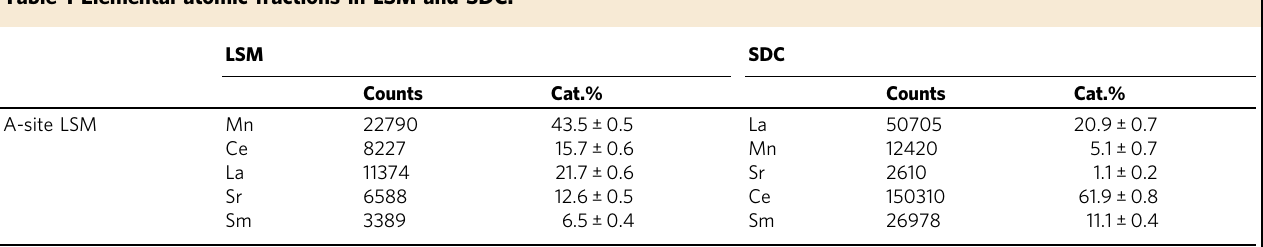
These were calculated from the core regions of each phase, excluding the interfacial regions. The uncertainty values are taken from dividing the LSM phase into 7 regions and the SDC phase into 30 regions and taking the standard deviations of the compositions from each of the individual